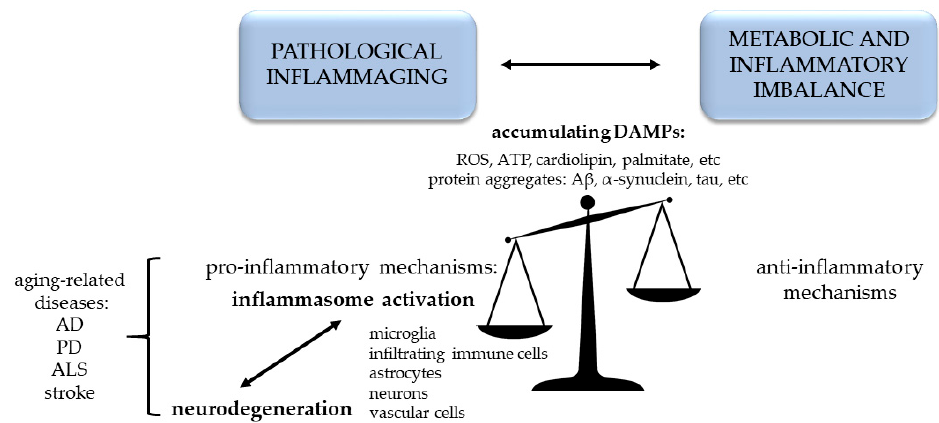
Figure 2. Pro-inflammatory shift in pathological aging. A β : amyloid- β , AD: Alzheimer’s disease, ALS: amyotrophic lateral sclerosis, ATP: adenosine triphosphate, PD: Parkinson’s disease, ROS: reactive oxygen species.